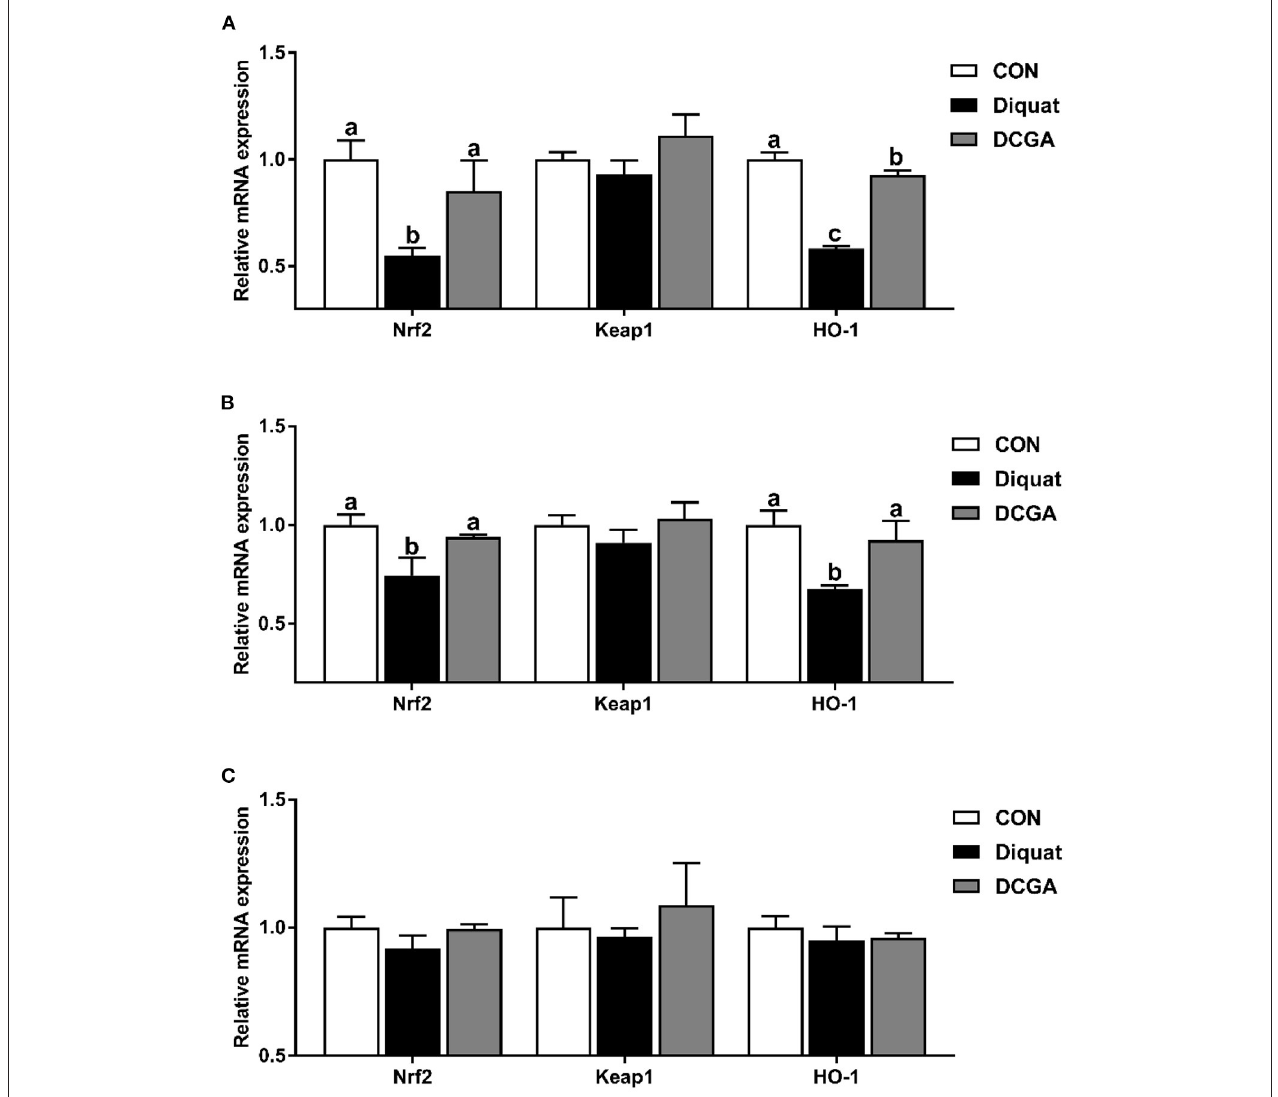
FIGURE 6 | Effects of CGA on expression levels of intestinal antioxidant-related key genes in the Duodenum (A) , Jejunum (B) , and Ileum (C) . Nrf2, nuclear factor erythroid-derived 2-related factor 2; Keap1, Kelch-like epichlorohydrin–associated protein 1; HO-1, heme oxygenase-1; CON, piglets fed a basal diet; Diquat, piglets fed the basal diet and challenged by diquat; DCGA, piglets fed the basal diet containing CGA (1,000 mg/kg) and challenged by diquat. a,b Bars with different letters between treatment groups indicate significant differences ( P <